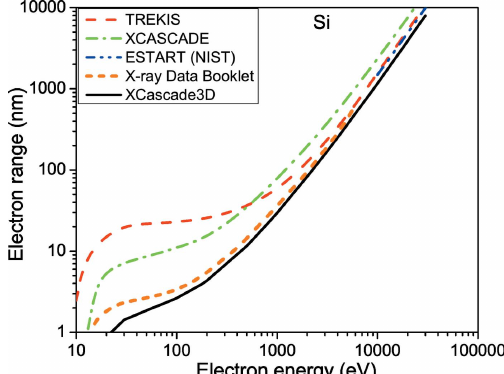
Figure 2 Electron range in silicon according to XCascade3D simulations – solid black line; XCASCADE estimation within the continuous-slowing-down approximation – green dash-dotted line; energy loss function integral from the NIST database – blue dash-dot-dotted line (Berger et al. , 1998); TREKIS simulation tool – red dashed line (Medvedev et al. , 2015); X-ray Data Booklet – orange short-dashed line (Thompson et al. , 2009).